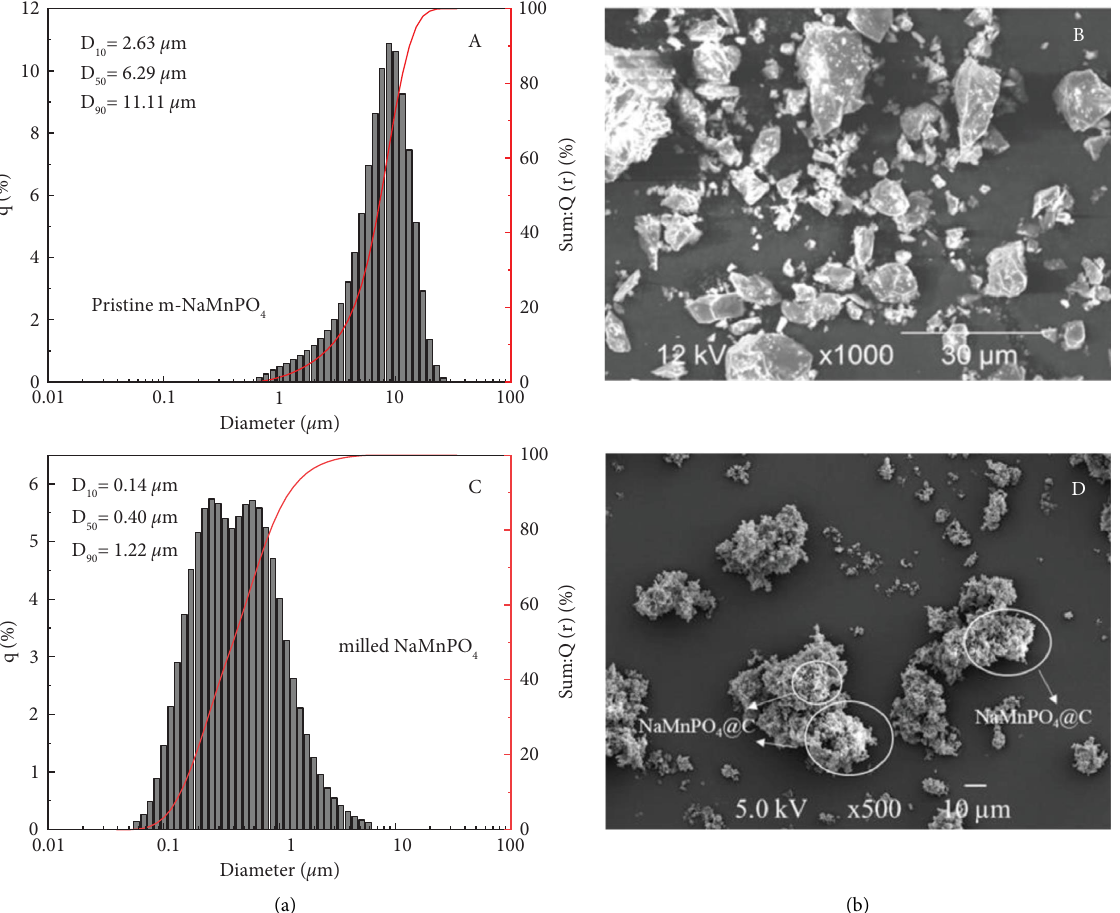
Figure 2: Particle size distribution (a) and SEM images (b) of NaMnPO NaMnPO 4 .